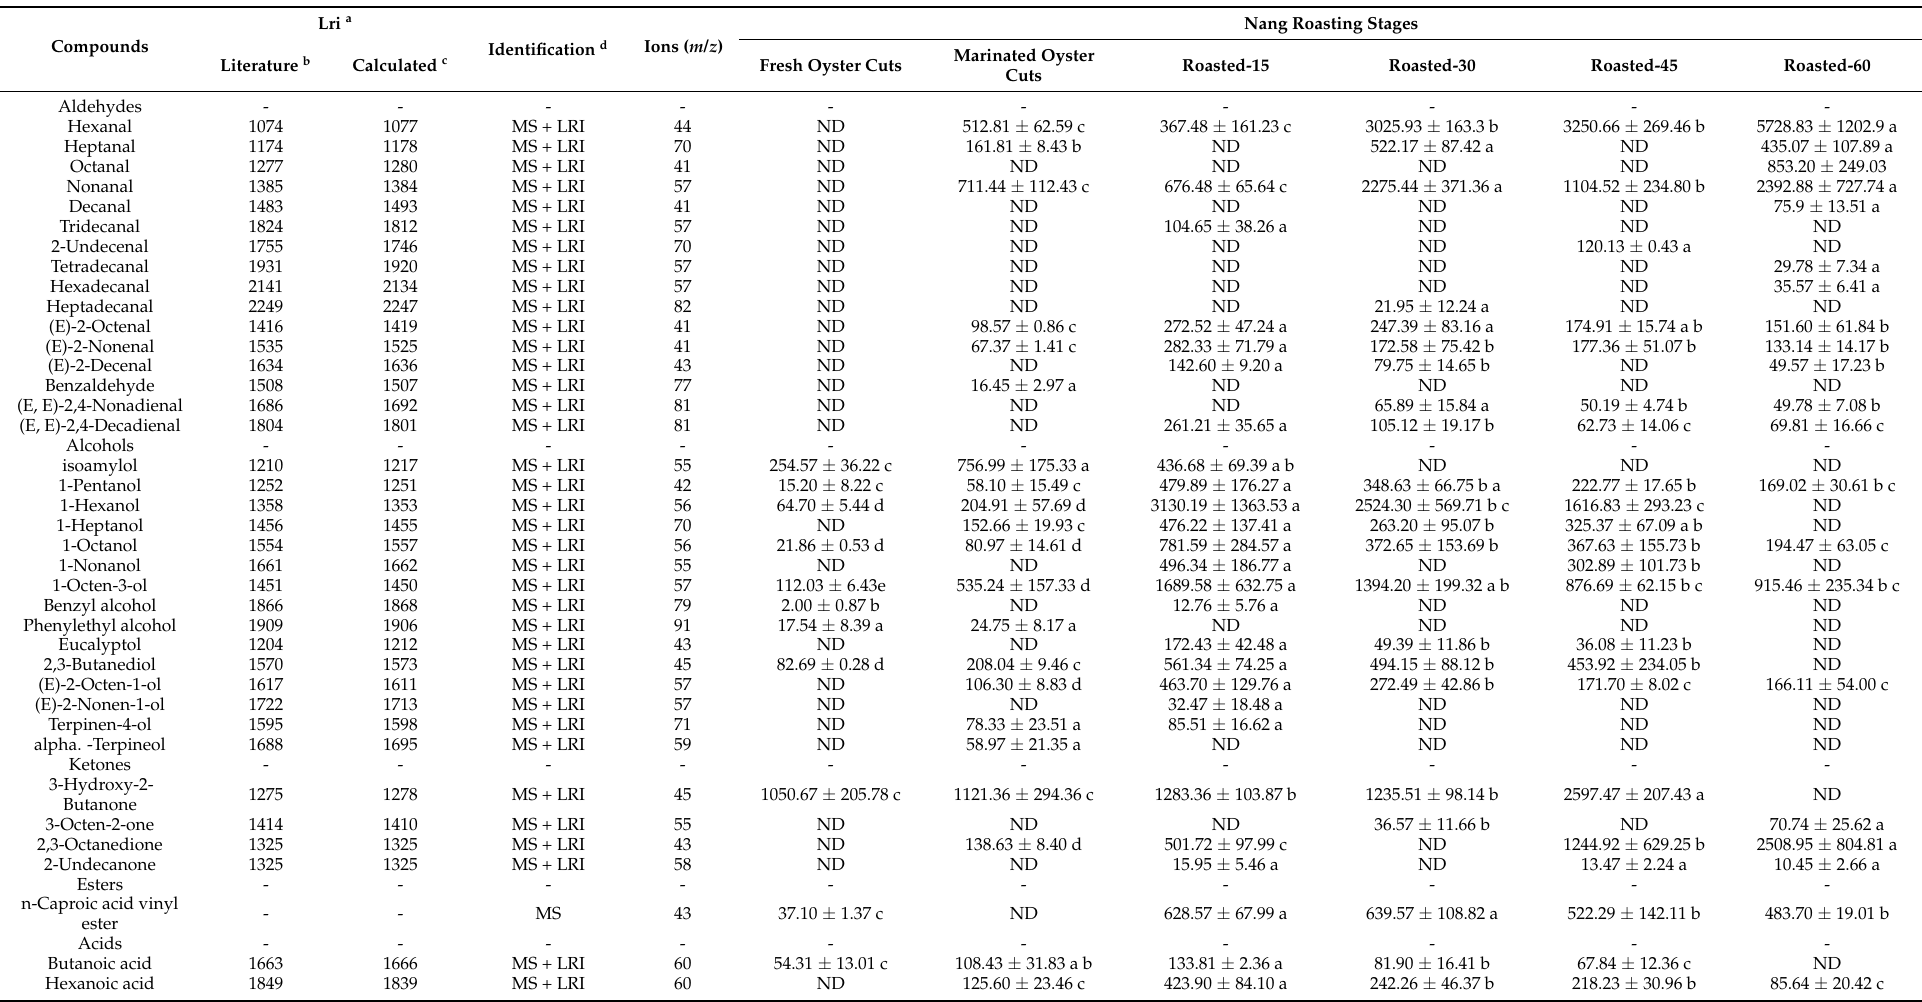
Table 2. Contents of the volatile compounds in lamb oyster cuts during Nang roasting